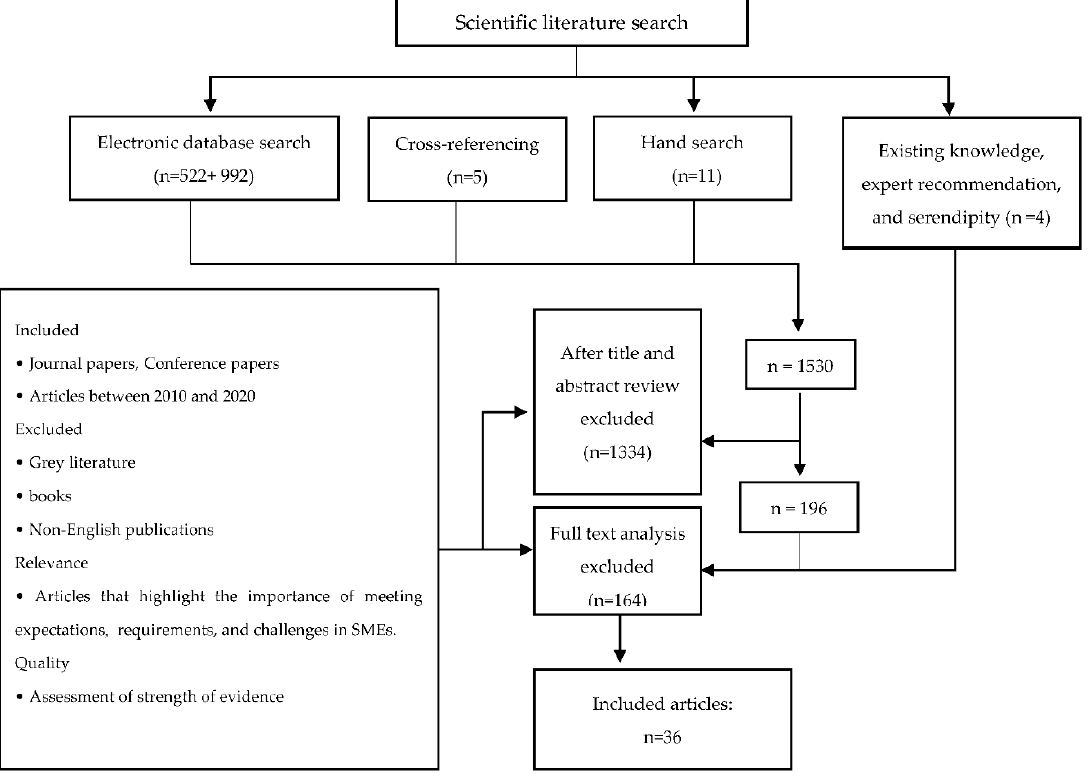
Figure 2. Research strategy (adapted from Smart et al. [15]).